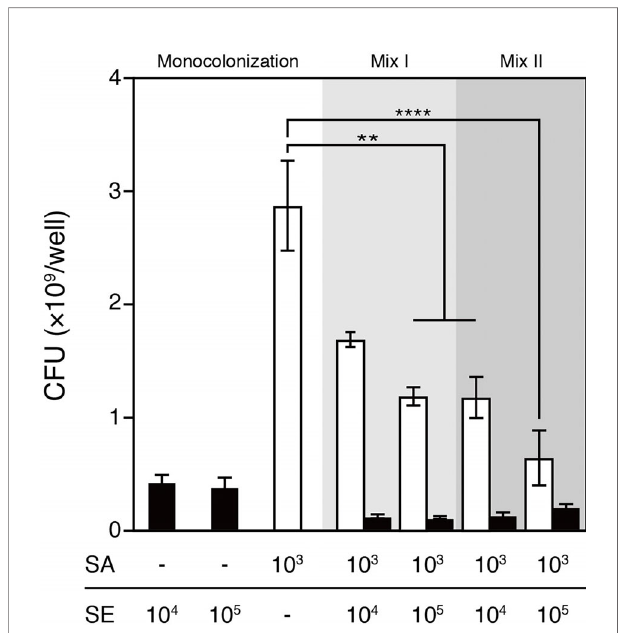
FIGURE 2 | Viable counts of S. aureus and/or S. epidermidis that colonized the surface of the 3D epidermal model after 48h cultivation. The viable counts of S. aureus were signi fi cantly lower in the coculture with S epidermidis than in S. aureus monoculture. Increasing the infective dose of S. epidermidis from 10 4 to 10 5 CFU/well or inoculating S. epidermidis 4h prior to S. aureus further reduced the viable counts of S. aureus that colonized the epidermal surface. SE, S. epidermidis (black bars); SA, S. aureus (open bars); Mix I, S. epidermidis and S. aureus were inoculated simultaneously; Mix II, S. epidermidis was inoculated 4h prior to S. aureus . Data are presented as mean ± S.E. (n = 3-6). **p ≤ 0.01, ****p ≤ 0.0001. Tukey – Kramer Post Hoc test after One-way analysis of variance